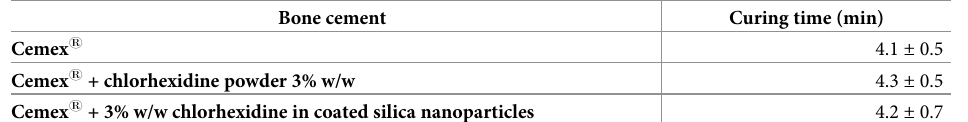
Table 2. Curing times in minutes (mean and standard deviation) Cemex 1 bone cement, Cemex 1 containing chlorhexidine 3% w/w as powder or through coated silica